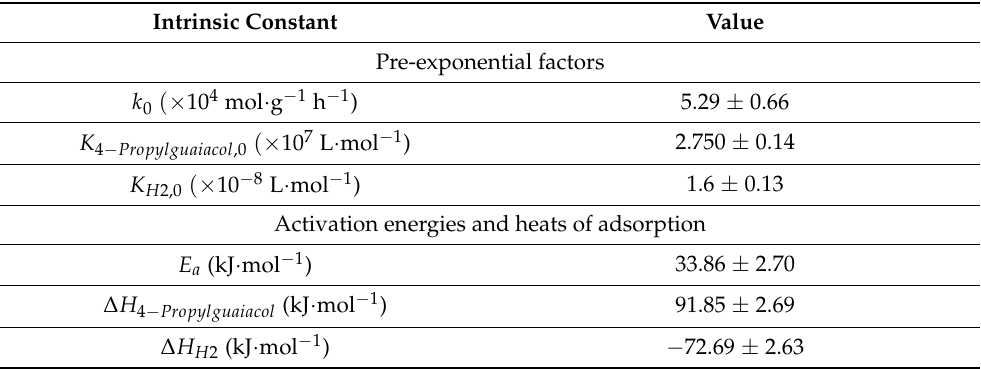
Table 3. Reaction Pre-exponential factors, activation energy and heats of adsorption [3]. Reproduced from Ref. [8] with permission from the Royal Society of